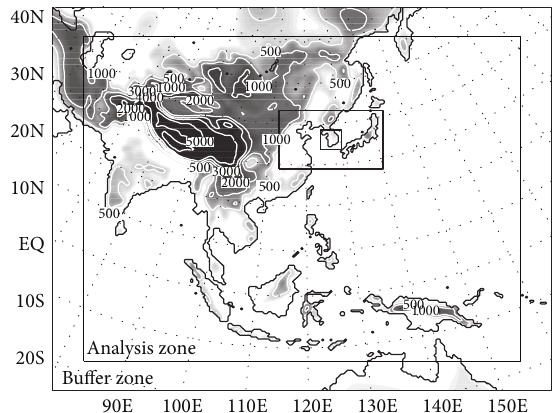
Figure 1: Regional model domain and orography (m). Primary, sec- ondary inner, and innermost boxes indicate analysis zone excluding buffer zone, Northeast Asia, and Korea, respectively.